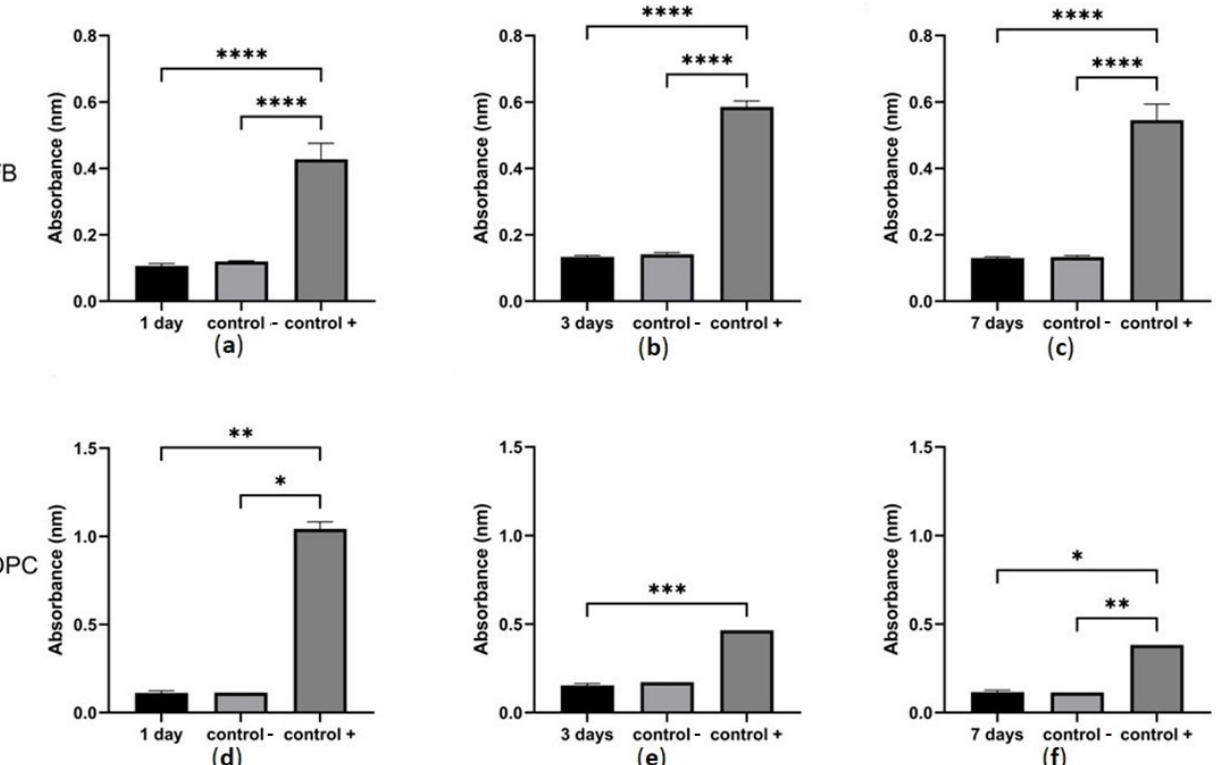
Figure 4. LDH activity measured at the ( a ) 1st, ( b ) 3rd, and ( c ) 7th days of indirect treatment of fibroblasts (FB) and the ( d ) 1st, ( e ) 3rd, and ( f ) 7th days of indirect treatment of dental pulp cells (DPC) * p < 0.05, ** p < 0.01, *** p < 0.001, **** p < 0.0001.